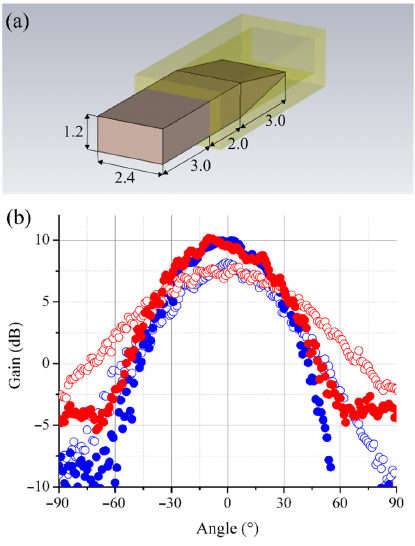
Figure 10. ( a ) A 3D model of the dielectric rod antenna, which is intended for providing the LO power to the array receiver. The dimensions are given in mm. ( b ) The gain of an open end of the waveguide (open circles) and the dielectric rod antenna (filled circles) at the E-plane (red circles) and at the H-plane (blue circles). A smooth shape of the rod antenna radiation pattern does not ensure a smooth shape of the LO power distribution at the focal plane. For that reason, exploration of this distri- bution was conducted. A vector network analyzer (VNA) was used for measuring the S 21 parameter, where the first port was the rod antenna, and the second port was a probe antenna moved at the focal plane. The probe antenna is an open end of the 2.4 × 1.2 rec- tangular waveguide with modified form of the outer walls for reducing scattering. The positioning accuracy of the probe antenna is 0.1 mm. The measured LO power distribution shown in Figure 11 indicates the presence of power inhomogeneity that achieves up to 27 dB in the region where the array is located. A possible reason for this inhomogeneity is related to cutting the rod antenna radiation pattern with the lens frame. The inhomogene- ity could be reduced by narrowing the radiation pattern or by increasing the diameter of the lens.